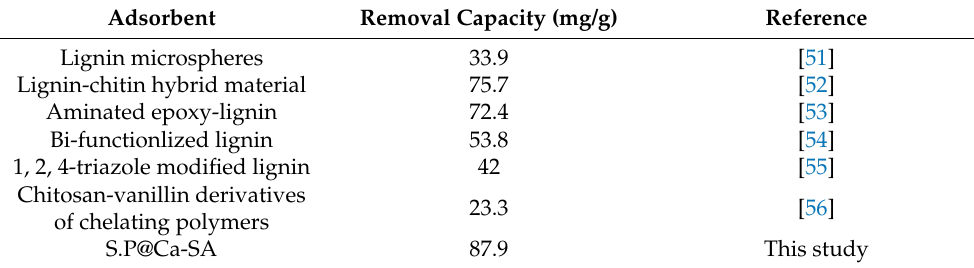
Table 4. Pb removal capacities of various biomass-based adsorbents reported in the literature. Adsorbent